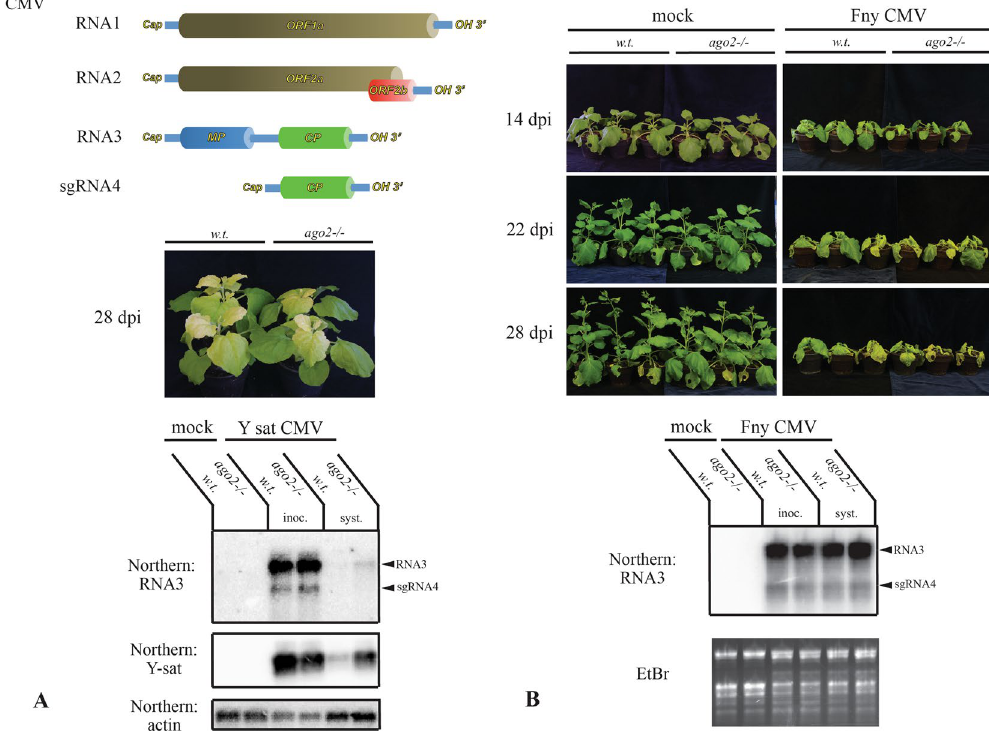
Figure 6. CMV infection is not affected by AGO2 deficiency in N. benthamiana . ( A ) Wild-type and ago2 N. benthamiana plants were infected with sap produced from Y-sat CMV infected N. benthamiana . Photographs of infected plants were taken at 28 dpi (top panel). At 14 dpi, RNA was prepared from the inoculated and the first systemically infected leaves. Samples were prepared from three plants and pooled. Accumulations of CMV RNA3 and sgRNA4 were monitored by northern blot using an RNA3-specific probe (second panel). Arrowheads indicate CMV RNA3 and sgRNA4. Y-sat levels were also analyzed by northern blot (third panel). The same filter was also hybridized with an actin probe as a loading control (bottom panel). ( B ) Wild-type and ago2 N. benthamiana plants were infected with sap produced from Fny CMV infected N. benthamiana . Mock infections were also performed with sap of uninfected plants. To monitor the progression of CMV infection, photographs of infected plants were taken at 14 dpi, 22 dpi and 28 dpi. At 7 dpi, RNA was prepared from the inoculated and the first symptomatic non-inoculated leaves. Samples were taken from three plants and pooled. Accumulations of CMV RNA3 and sgRNA4 were monitored by northern blot using an RNA3-specific probe. Arrowheads indicate CMV RNA3 and sgRNA4. Ethidium-bromide stained gel is shown as loading